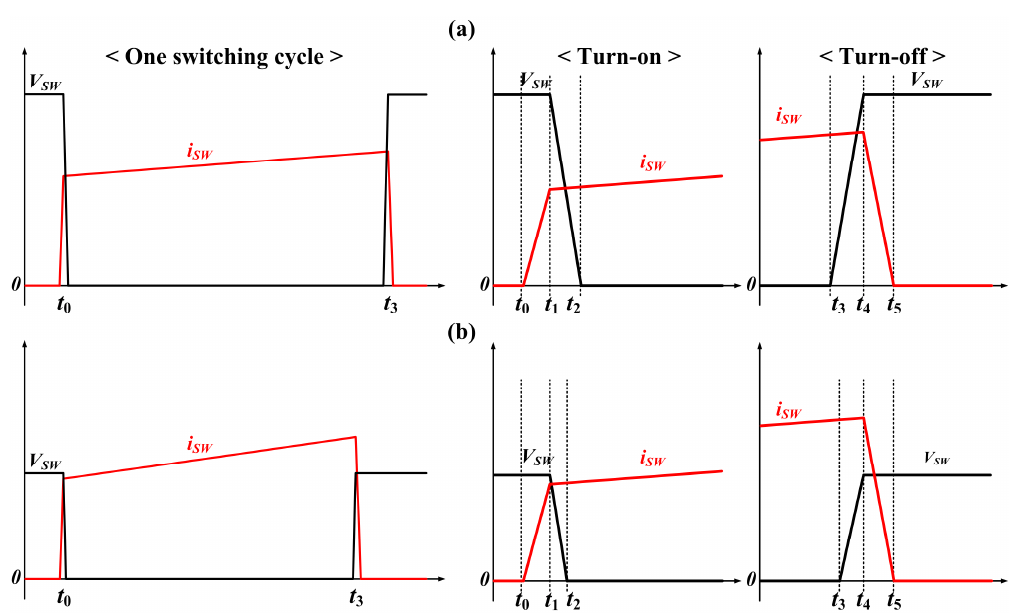
Figure 3. Voltage and current waveforms of the switch: ( a ) conventional boost converter, ( b ) proposed converter.